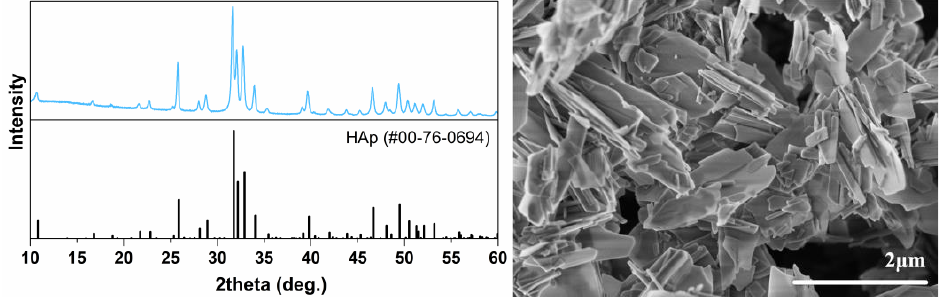
Figure 1. XRD pattern ( left ) and SEM image ( right ) of HAp prepared from α -TCP without addi-